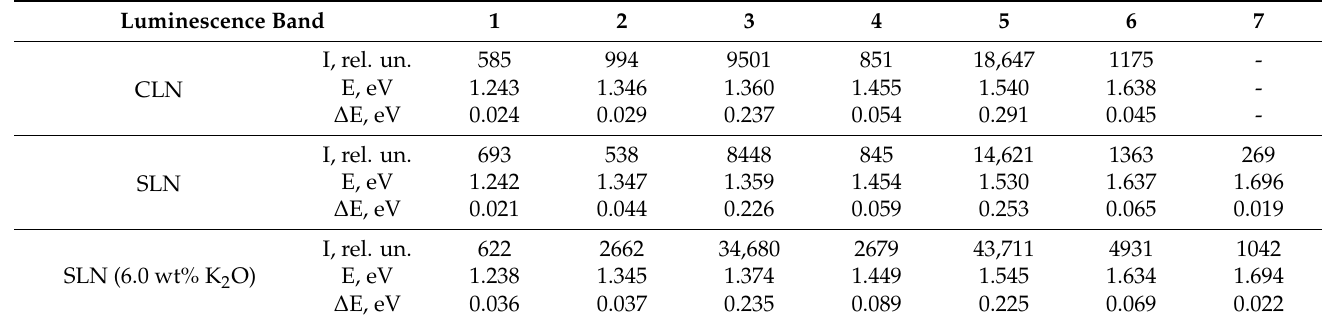
Table 4. Spectral characteristics of individual bands after the PL spectra decomposition of CLN, SLN and SLN (6.0 wt% K 2 O) crystals in the near-IR